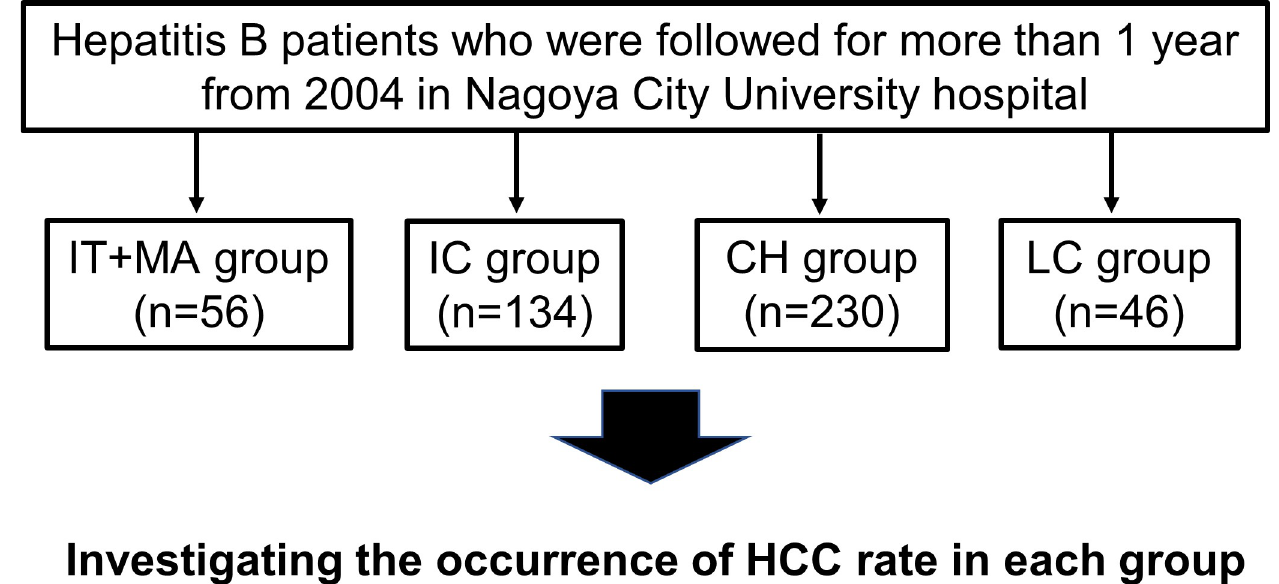
Fig 1. Patient flow chart. Abbreviations: IT+MA, immune tolerant + mildly active, IC, inactive carrier; CH, chronic active hepatitis; LC, liver cirrhosis; HCC, hepatocellular carcinoma.